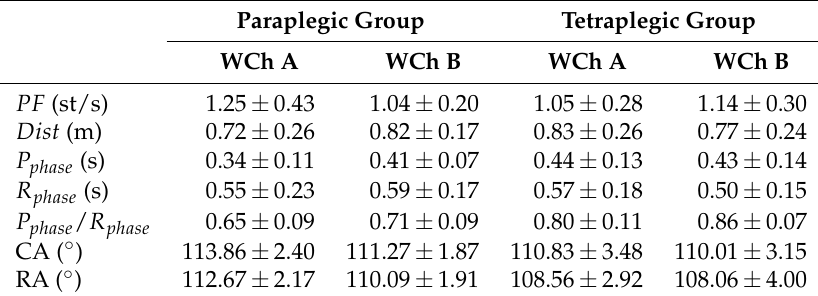
Table 6. Temporal–spatial variables (mean ±